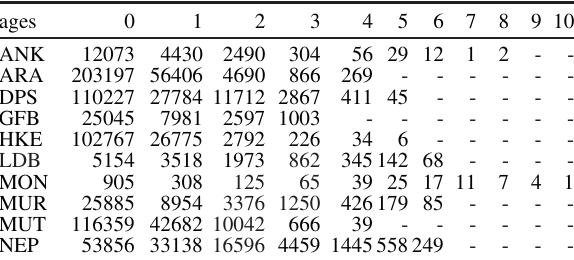
Table 5. – Stock numbers at age (thousands) resulting from the latest assessments (mean values of the last three years). Species codes as in Table 1.